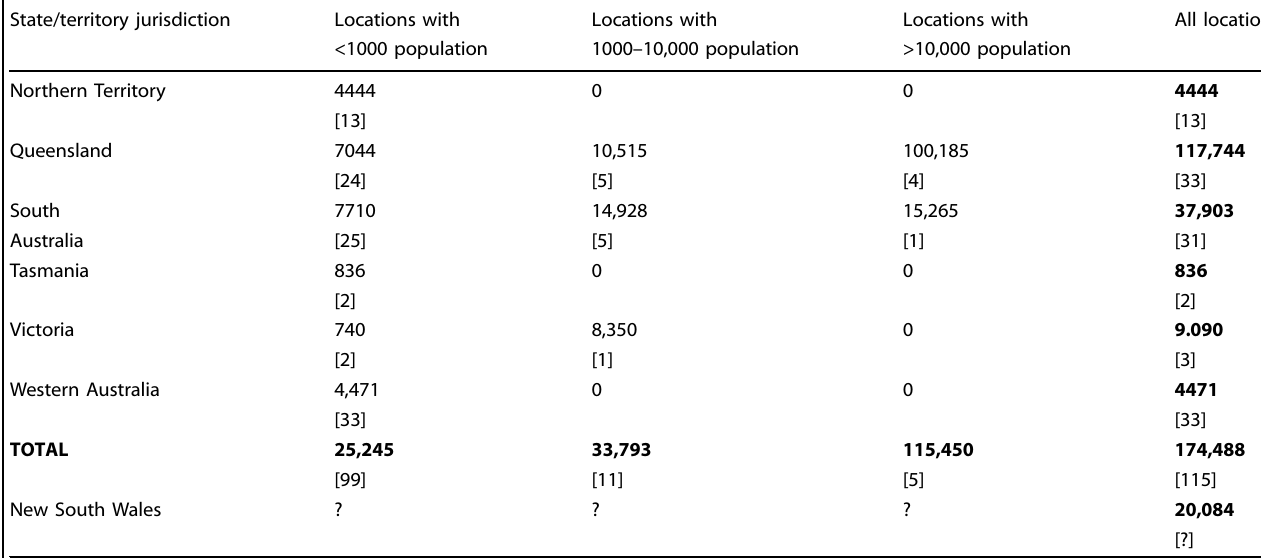
Table 3. Population and number of locations in regional and remote Australia reported to lack access to the ‘ ADWG Health ’ de fi nition of a basic level of drinking water